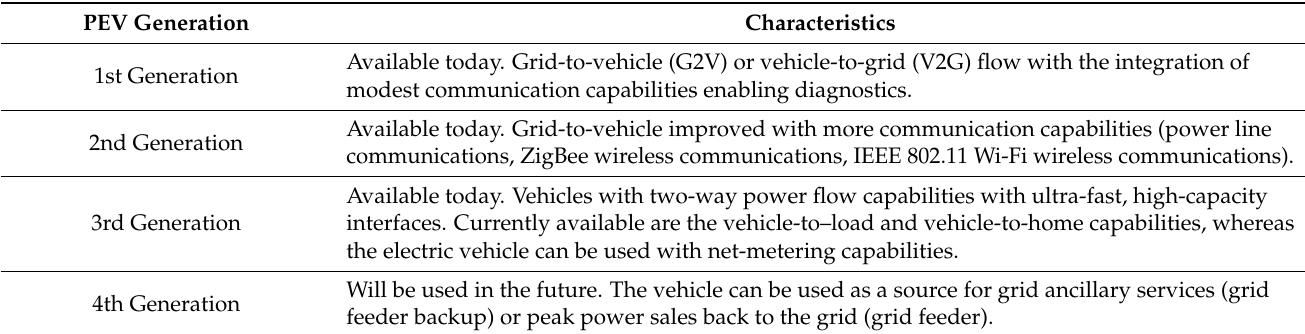
Table 3. Generations of plug-in electric vehicle (PEV) grid interactions [82].